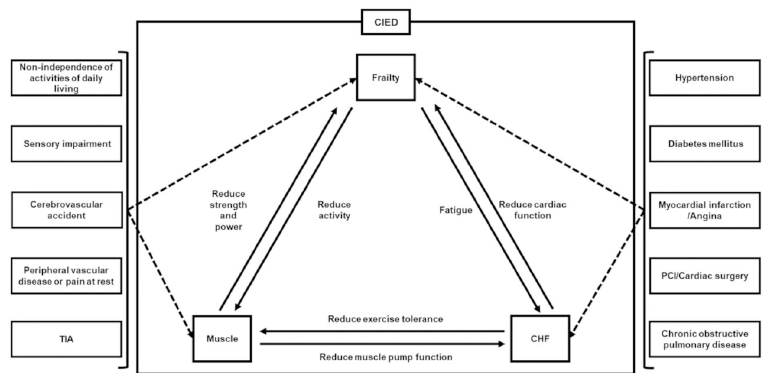
Fig 4. Correlation chart for frailty, heart failure, CIED patients, and other mFI factors. Frailty and muscle are affected by ADL, sensory impairment, CVD, PVD, and TIA. Frailty and CHF are affected by hypertension, diabetes mellitus, MI, anginal pain, PCI, and cardiac surgery. Muscle and frailty are associated with decreased muscle mass and strength and decreased activity. Muscle and CHF are related to exercise tolerance and muscle pump action. Frailty and CHF are related to cardiac dysfunction and fatigue. Abbreviations are the same as in Table 1 and Fig